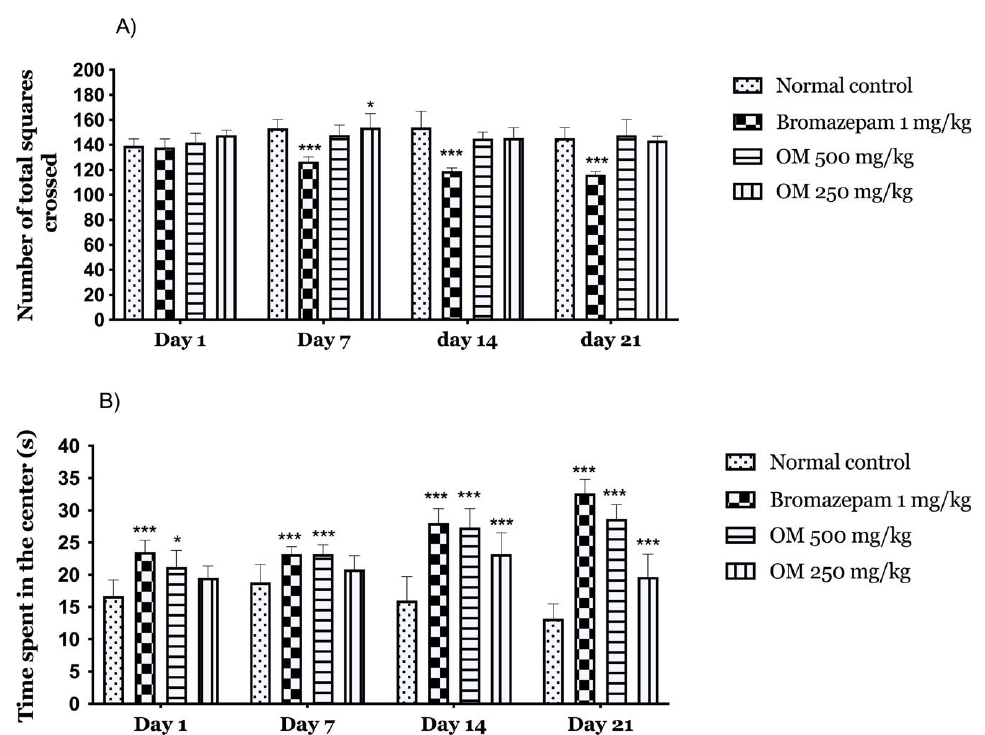
Figure 3. Temporal effects of OM in the open field test. ( A ) Number of total squares crossed ( B ) time spent in the center. Values are expressed as mean ± SEM. The analysis was done using two-way repeated-measures analysis of variance followed by Dunnett post hoc test *** p < 0.001, * p < 0.05 compared with normal